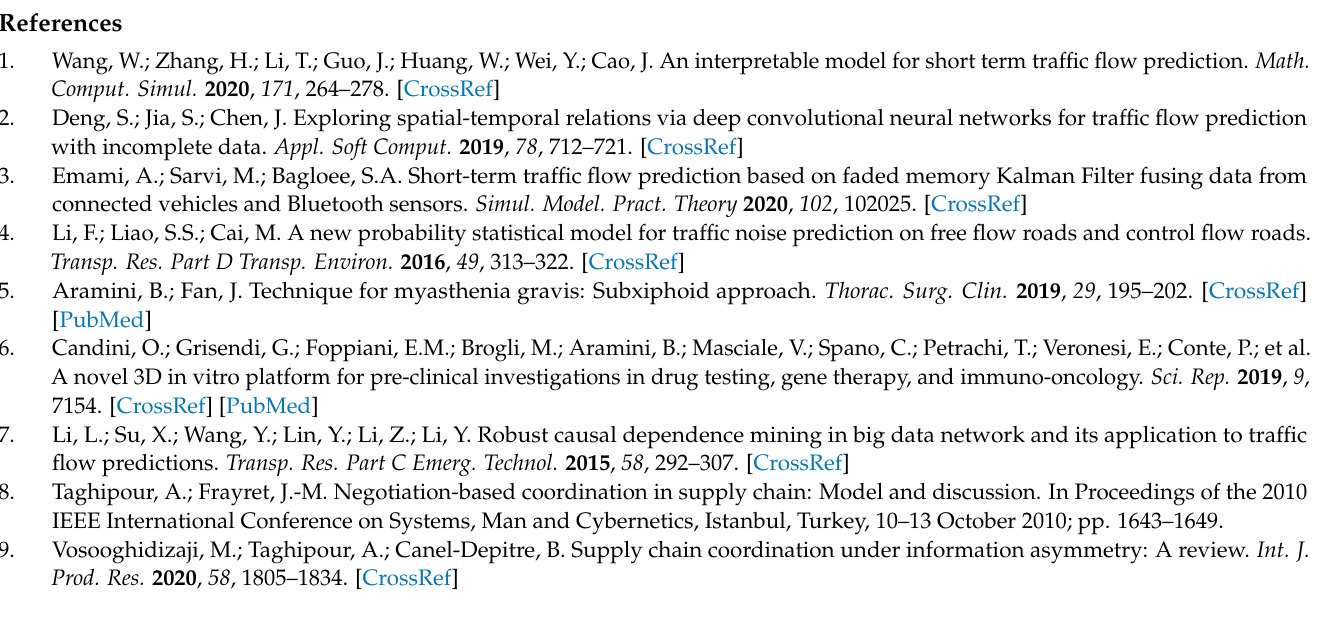
Figure A5. N17 Freeway